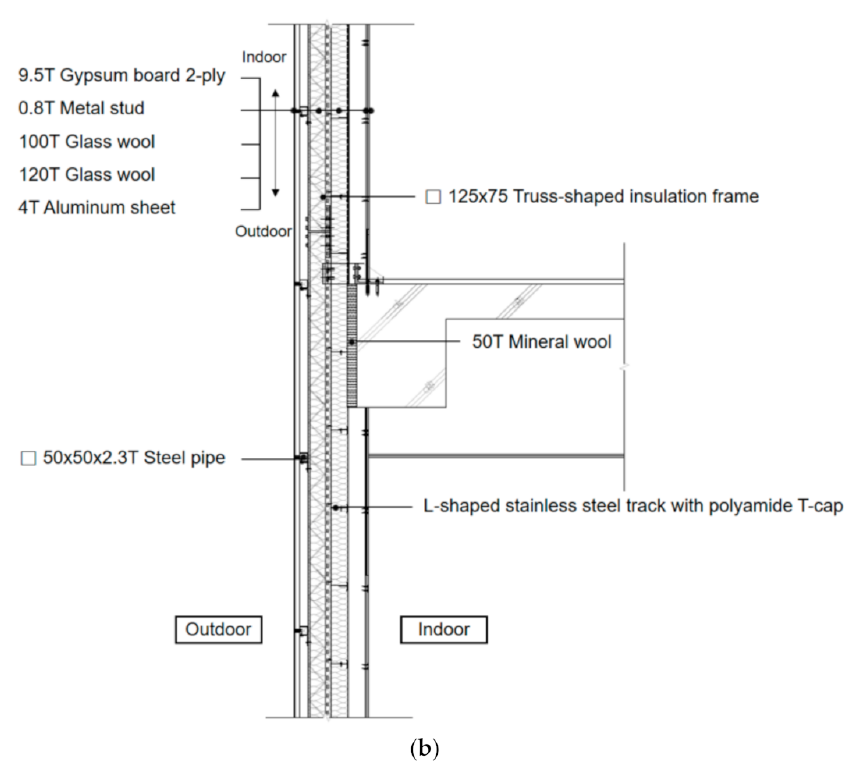
Figure 8. Vertical sections of the simulation models: ( a ) base case; ( b ) alternative case.